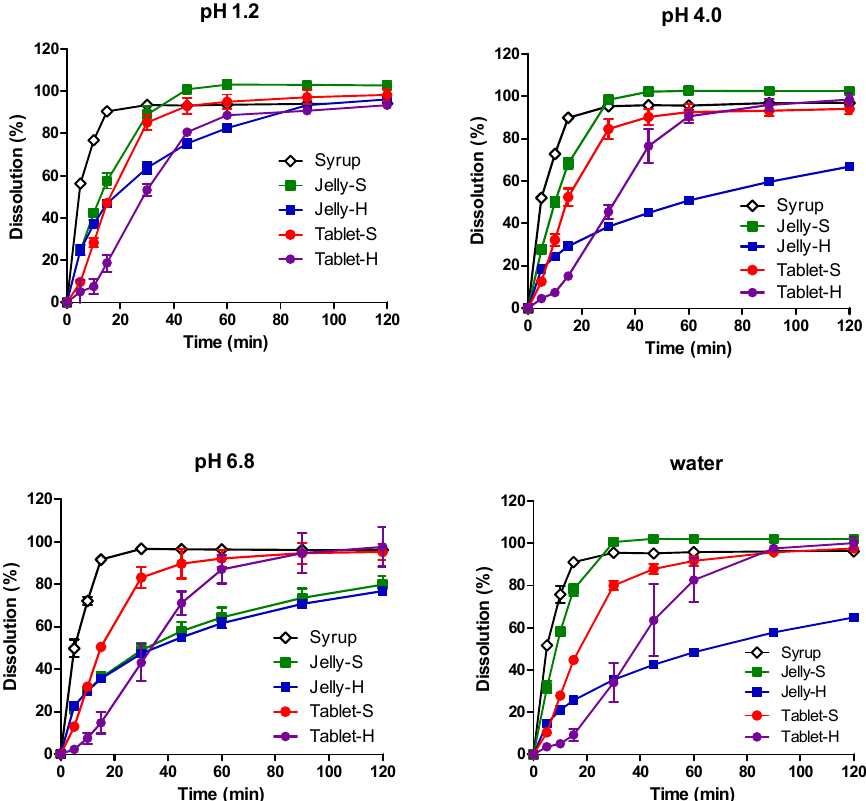
Figure 1. Dissolution profiles of acetaminophen from various formulations in pH 1.2, 4.0, 6.8, and water at 37 °C. Each point represents mean ± standard deviation ( n = 6).